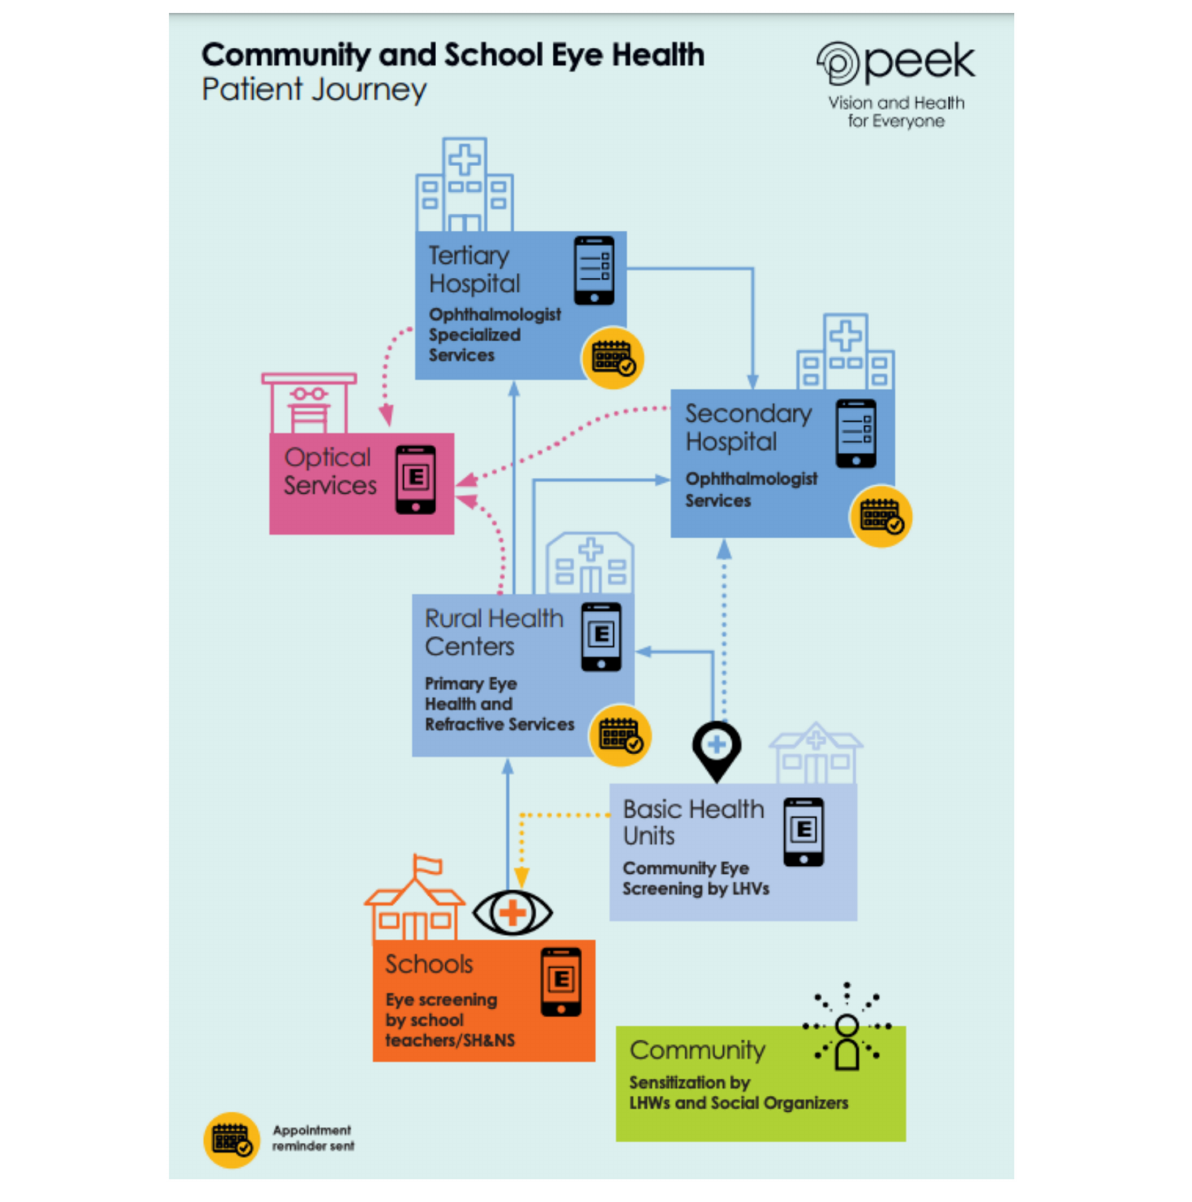
FIGURE1 The patient journey approach and referral pathway in the Pakistan eye health programmes. LHWs, Lady Health Workers; LHVs, Lady Health Visitors; SH&NS, School Health and Nutrition